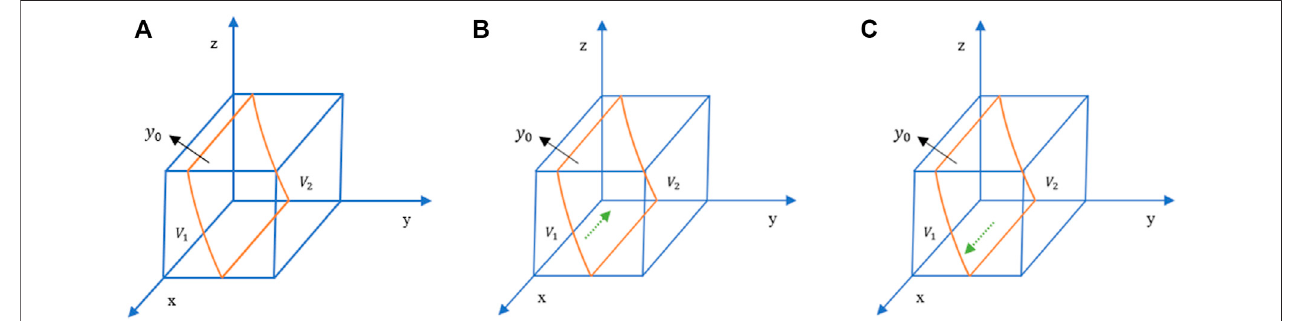
FIGURE 2 | Dynamic evolution trend of the behaviors of the Marine enterprises. (A) y = y 0 . (B) y < y 0 . (C) y > y 0 .